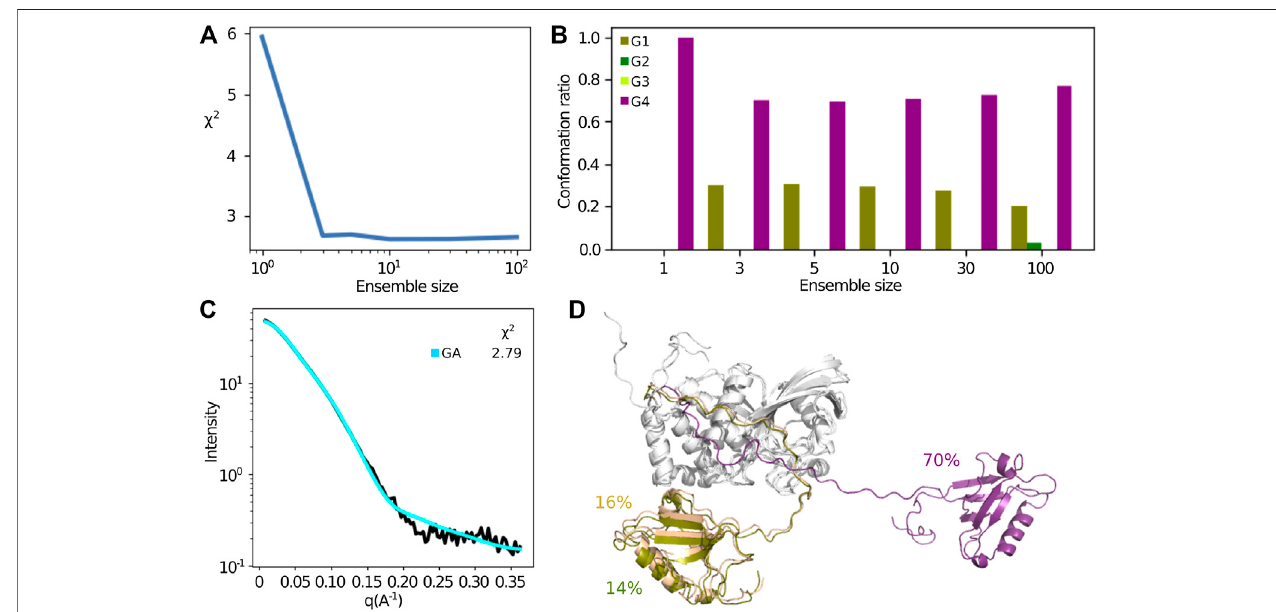
FIGURE 10 | Extracting a minimum subset of conformations from the MD simulations, that describes best the SAXS data using a genetic algorithm. (A) Improvement of the χ 2 with respect to the ensemble size in the genetic algorithm selection. (B) The conformations are clustered in four categories according to the clustering obtained using SOM; conformations in the groups G1, G2, G3, and G4 are colored in olive, green, yellow-green and purple bars, respectively. The proportion ofeachgroup isrepresentedforeach ensemble size. (C) Back-calculatedSAXSpro fi le usingthegeneticalgorithmderivedfromtheensemblesizeofthree(in blue) and theexperimentalpro fi le (in black),with the χ 2 (cid:2) 2.79. (D) Representative ensemble ofPTPN4 superimposed on PTPshowingthe PDZ in G1conformation (oliveand khaki) or in G4 conformation (purple) with the proportion of each